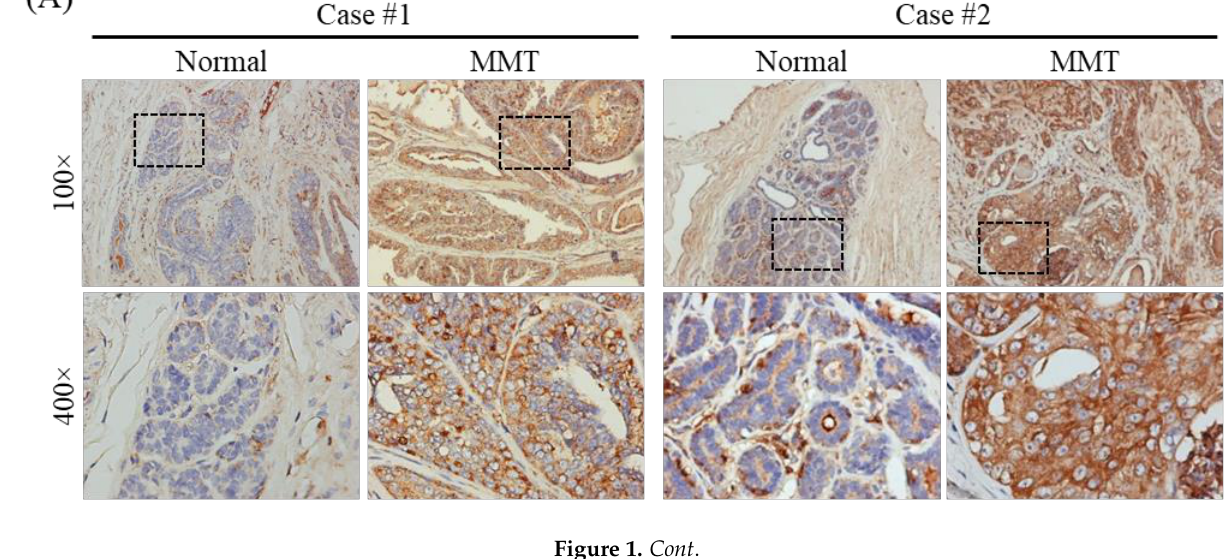
Figure 1. AGR2 overexpression in canine MMT tissues revealed by immunohistochemistry (IHC). AGR2 protein expres- sion was analyzed with tissue slides of 34 canine MMT cases using an antibody specific to AGR2. ( A ) Micrographs of two representative cases. Upper micrographs were acquired at 100× magnification; bottom micrographs were the areas in the upper images acquired at 400× magnification. ( B ) MMT tissues stained with an isotype control IgG. ( C ) Pairwise compar- ison of IHC scores of AGR2 between MMT tissue and adjacent normal mammary gland tissue of the same patient. Each line represents an individual patient . Statistical significance was determined by two-tailed paired t -test. ( D ) C omparison of IHC scores of AGR2 between overall MMT tissues and adjacent normal mammary tissues. L, M, and H denote low, moderate, and high levels of AGR2, respectively. Statistical significance was determined by Fisher’s exact test. ** p < 0.01; *** p < 0.001. Furthermore, AGR2 overexpression in MMT tissues was also validated by immunob- lotting analysis using MMT and paired normal mammary gland tissues of another 11 MMT dogs. Results revealed that AGR2 protein levels were significantly elevated in tu- mor tissues compared with paired normal mammary gland tissues collected from the same patient (Figure 2A,C), in consistence with the IHC data. Collectively, AGR2 was overexpressed in overall MMT tissues and even in BMT tissues compared with the normal counterparts (Figure 2B). These data indicated a significant association of AGR2 expres- sion level with canine MMT.